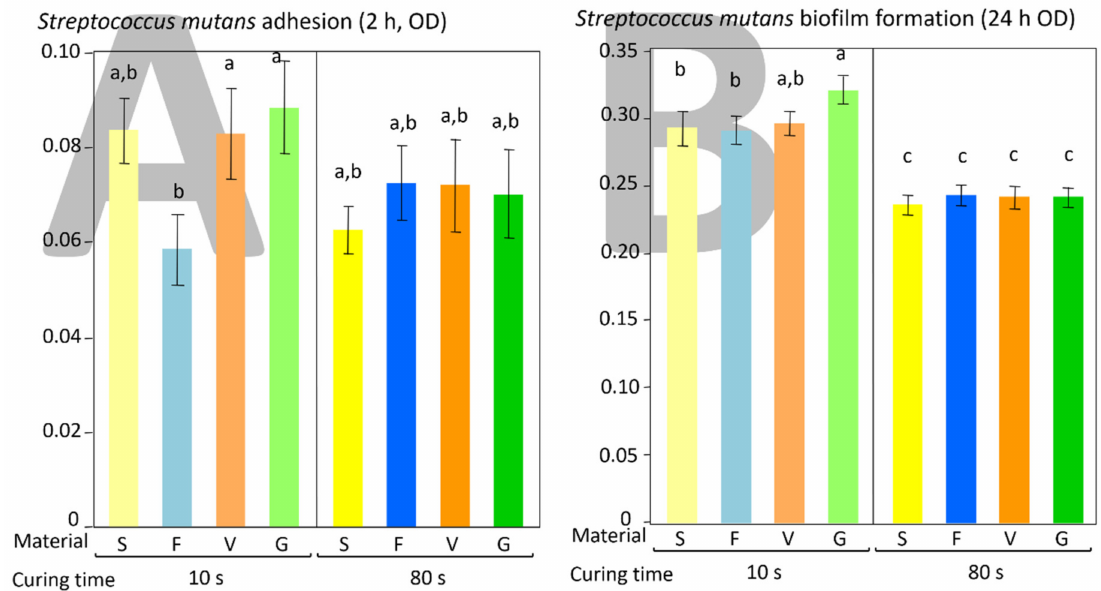
Figure 4. Results of the microbiological behavior of the tested materials in terms of bacterial adherence ( A ) and biofilm formation ( B ) by S. mutans . A highly significant decrease in both adherence and biofilm formation can be observed on materials cured for an extended time (80 s). Interestingly, differences in adherence and biofilm formation between materials disappeared after extended curing time (80 s). Different superscript letters indicate significant differences between materials (Tukey’s test, p < 0.05) for a given